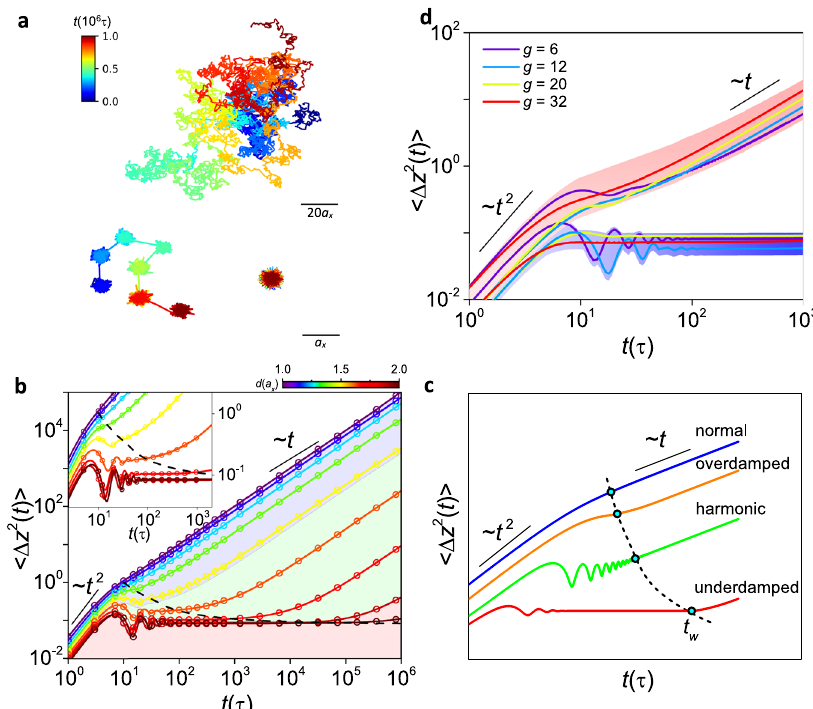
Fig. 5 Topological effect on microscopic dynamics. a Representative trajectories of Brownian (top), hopping (left) and trapped (right) dynamics in the macromolecular network at g = 6, where the diameter of particle d / a x = 1.00, 1.65, and 1.90, respectively. Time scale is color-coded at the top-left corner, and length scales are shown on the right bottom of each plots. b 〈 Δ z 2 ( t ) 〉 as a function of t for different d / a x at g = 6. The solid line denotes the theoretical results predicted by Eqs. 3, 5 – 7, and the hollowed scatters mark the results obtained from numerical simulations. The color of lines and scatters indicates the value of d and is coded in the upper right panel. c Schematics of theoretical predictions of 〈 Δ z 2 ( t ) 〉 at Regimes I (red), II (green), III (orange) and IV(blue), where the oscillating state of each regime is labeled on the right of the plot. Circles denote the characteristic waiting time t w , and a dashed line connecting circles is used to guide to the eye, as also illustrated by the black dashed lines in Fig. 5b and its inset. d 〈 Δ z 2 ( t ) 〉 as a function of t for different topologies: g = 6 (purple), 12 (blue), 20 (yellow), 32 (red) at boundaries of Regimes II and III (upper, d = 2 r mid ) and Regimes I and II (bottom, d = 2 r out ), which are approximately grouped by the shaded